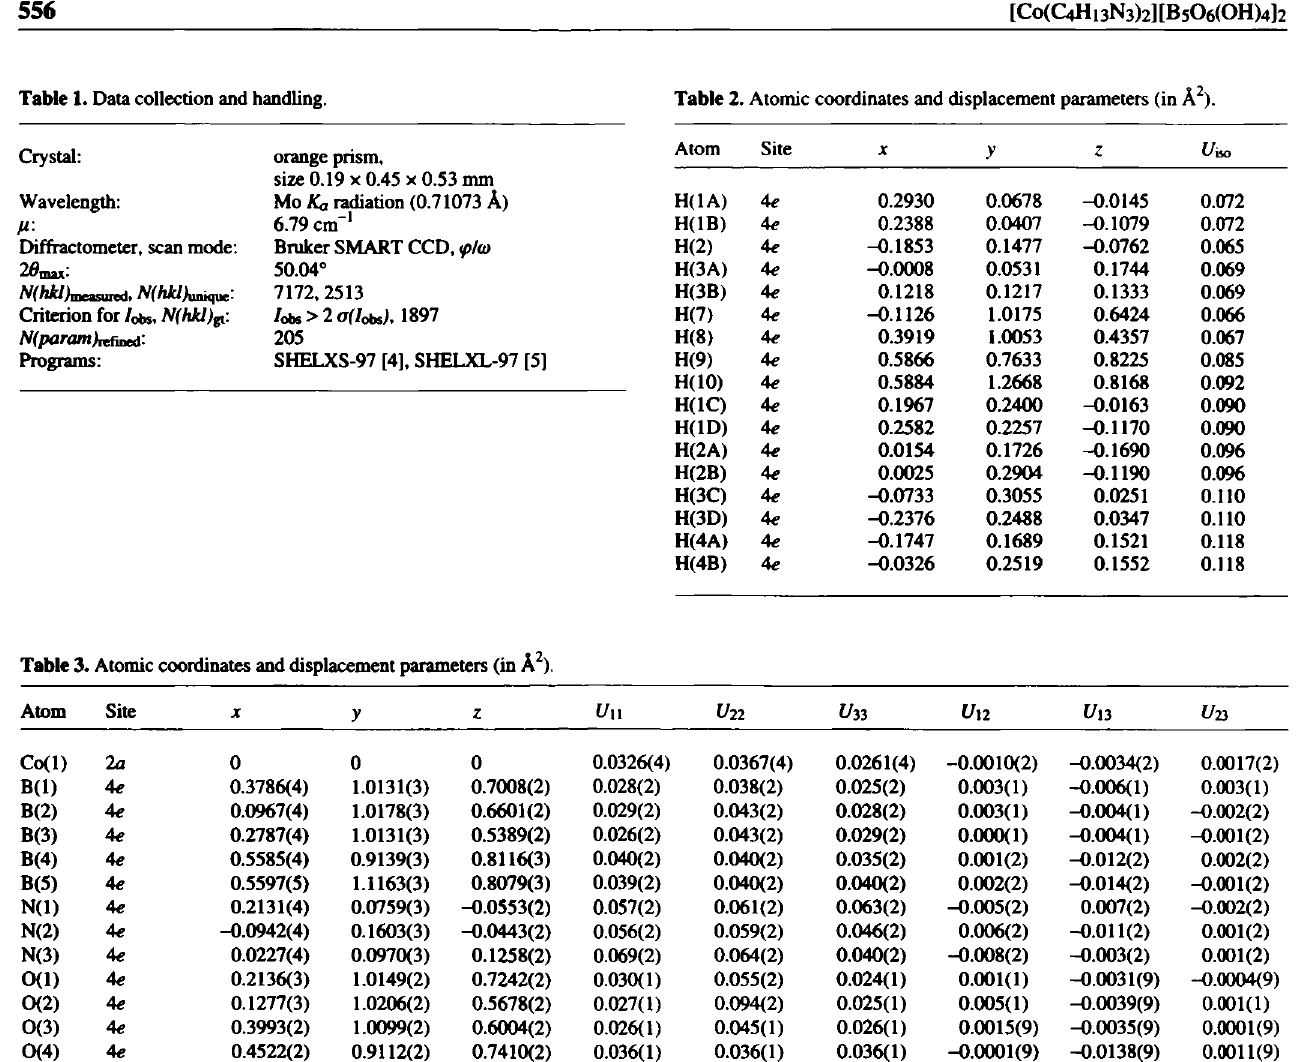
Table 3. Atomic coordinates and displacement parameters (in A 2